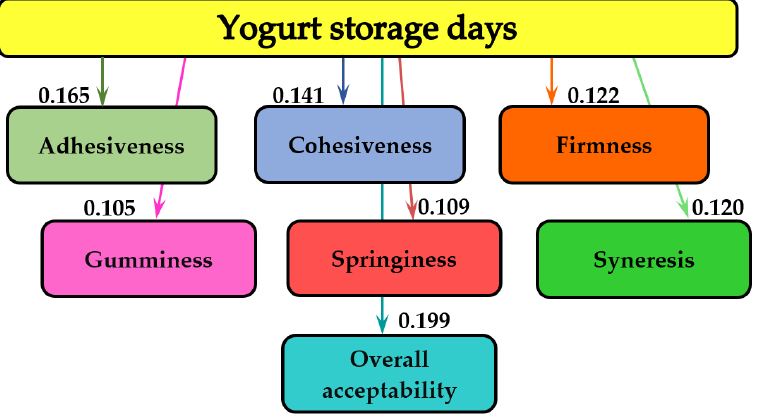
Figure 1. The informational analysis of the influence of storage days on textural parameters and overall acceptability of yogurt.